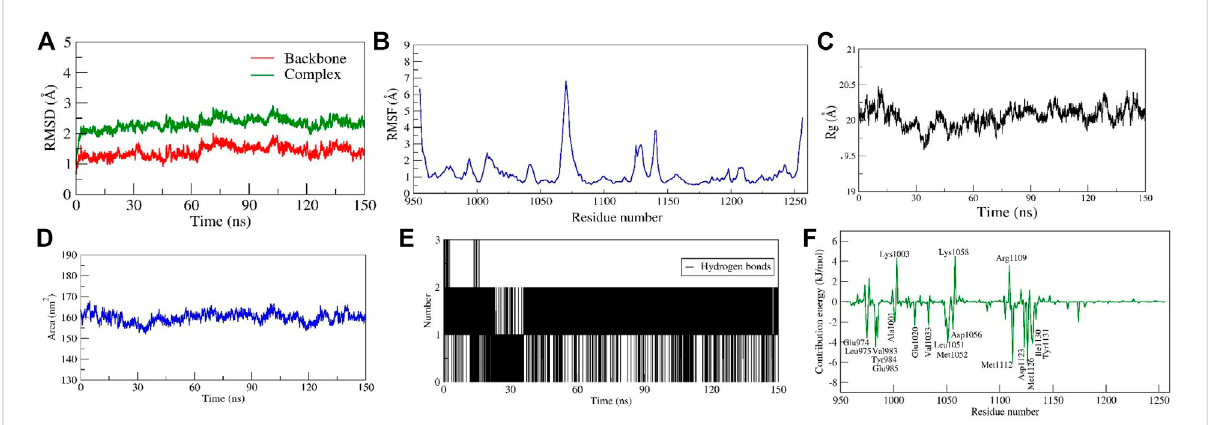
FIGURE 8 Parameters representing the structural stability of the Diosgenin-IGF1R complex. (A) Backbone and complex RMSD, (B) RMSF, (C) Rg, (D) SASA, (E) number of H-bond interactions, and (F) contribution energy plot demonstrates the signi fi cance of the ligand binding domain residues in stable complex